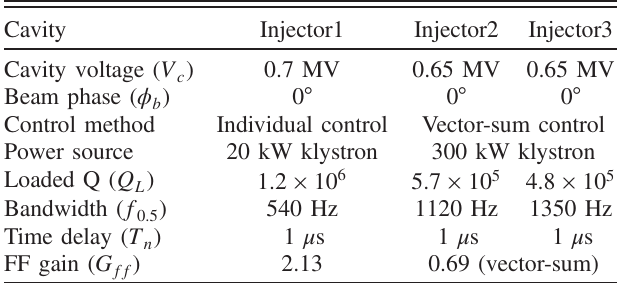
TABLE IV. LLRF and cavity parameters of injectors in the cERL.